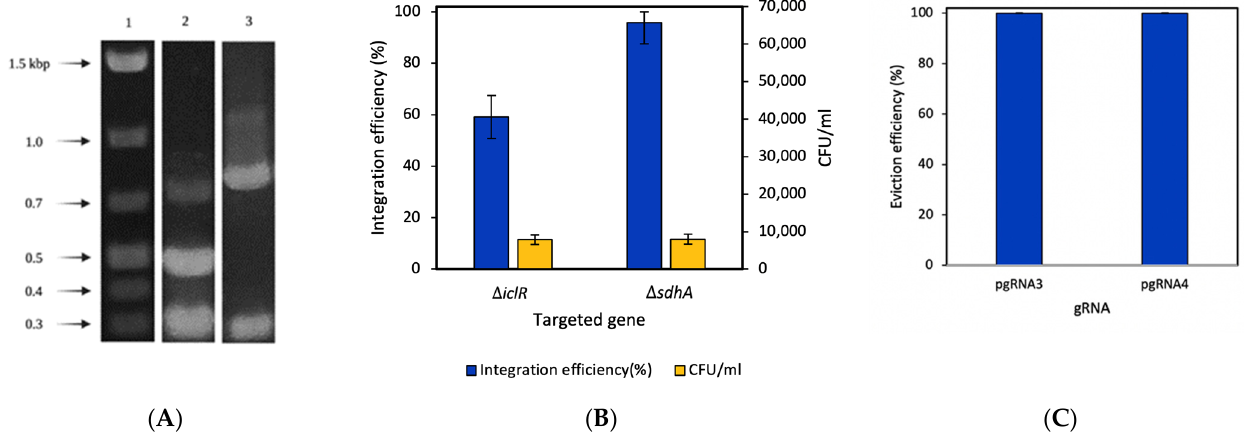
Figure 5. ( A ) Colony PCR screening of iclR and sdhA knockouts via λ Red recombineering (column 2–3). To screen for iclR knockout, primers P077/P078 amplified a 790 bp fragment and successful recombination of the editing template generated products of 490 bp and 300 bp upon AseI digestion (columns 2). To screen for sdhA knockout, primers P079/P080 amplified a 1065 bp fragment and successful recombination of the editing template generated products of 779 bp and 286 bp upon AseI digestion (column 3). ( B ) Gene knockout efficiency based on colony PCR (ratio of colonies containing the desired mutation to the total number of colonies screened for colony PCR) and colony count (CFU/mL) of each transformation employing λ Red recombineering system to knockout iclR and sdhA genes. ( C ) pgRNA plasmid eviction efficiencies confirmed by chloramphenicol sensitivity (ratio of colonies with successful plasmid eviction to total number of colonies screened for antibiotic sensitivity). All values are reported as means ± SD ( n = 3).